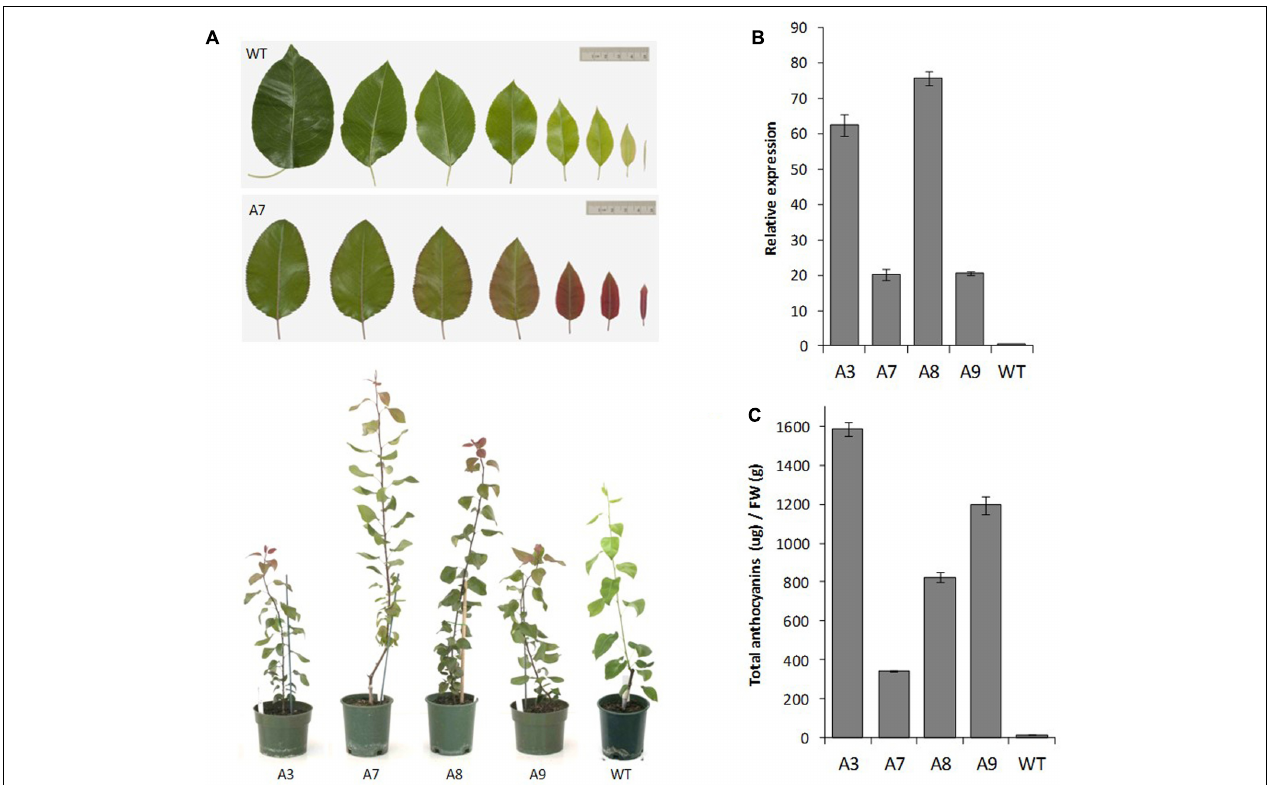
FIGURE 6 | Insertion of R6 domain into the pear MYB10 promoter induces PcMYB10 overexpression and ectopic anthocyanin accumulation. (A) Phenotype of representative transgenic pear lines harboring the PcMYB10-R6 pro :PcMYB10 construct. (B) Expression analysis by qPCR of the transcripts of the PcMYB10 gene in fully expanded mature leaves of each transgenic line. Expression is given relative to pear actin and error bars represent the standard errors of the means calculated from four technical replicates. (C) Total anthocyanin content of fully expanded mature leaves of each line measured by HPLC and expressed as µ g of Cy-glu equivalent per gram of fresh weight (FW). Error bars represent the standard errors of the means calculated from three